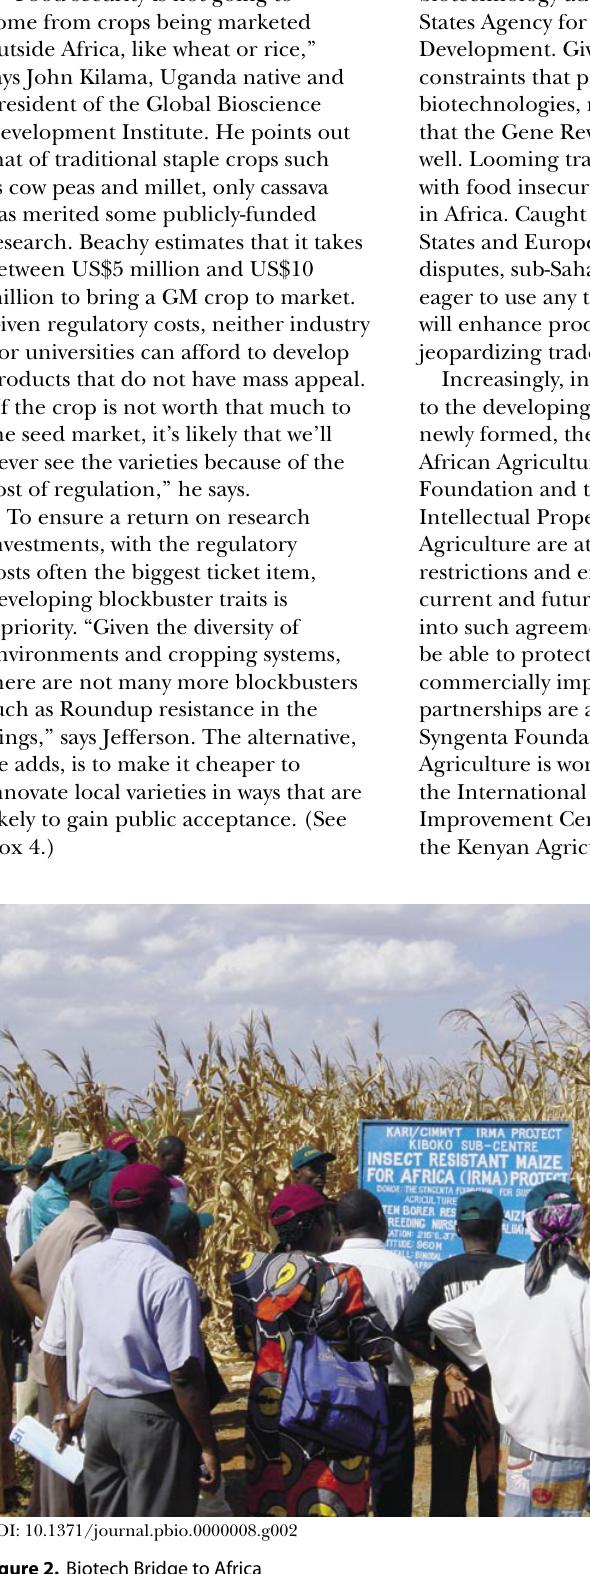
Figure 2. Biotech Bridge to Africa In an effort to reduce corn stem-borer infestations, corporate and public researchers partner to develop local Bt corn varieties suitable for Kenya. (Photo courtesy of Dave